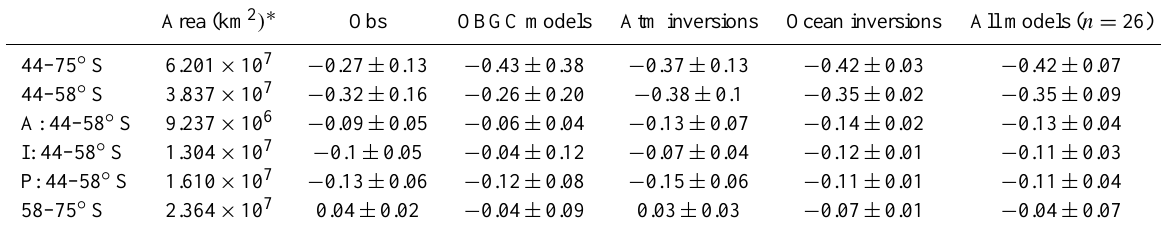
Table 3. The annual CO 2 uptake (negative into the ocean) from observations (with assumed 50% uncertainty) and multi-model median uptake (negative into the ocean) and median absolute deviation (MAD) from ocean biogeochemical models, atmospheric and ocean inversions, and all of the models. A, I, P refer to the Atlantic, Indian and Pacific Sectors of the Southern Ocean. All units are PgCyr − 1 .